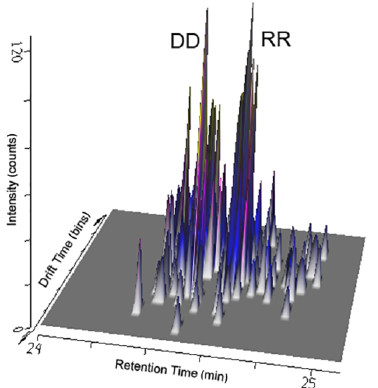
Figure 6. The combinative diagram of the CE retention time and the IMS drift time was drawn dur- ing the DD and RR peptide mixture separation. the DD and RR peptide mixture